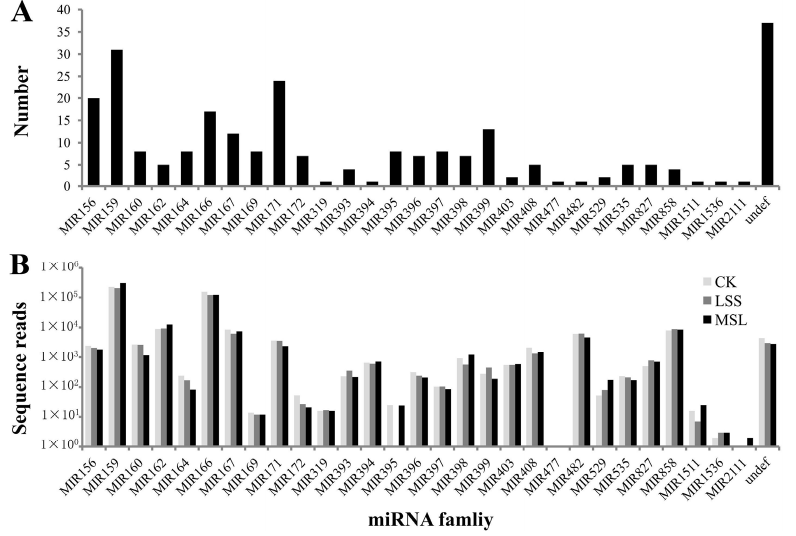
Figure 2. Number and abundance of conserved miRNAs for each miRNA family. ( A ) Number of conserved miRNAs for each miRNA family; ( B ) Abundance of conserved miRNAs for each miRNA family. CK, without salt stress; LSS, light salt stress for a short time; and MSL, medium ‐ heavy salt stress for a long time; Undef, conserved miRNAs that have not been classified into miRNA families in the miRbase database.